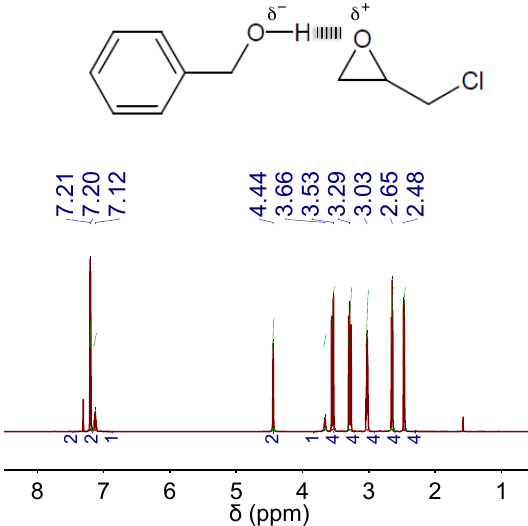
Figure 5. 1 H NMR spectra of a mixture of BA and EP in a molar ratio of 1:4. The chemical structures of EP and the H-bond complex formed between EP and BA are also